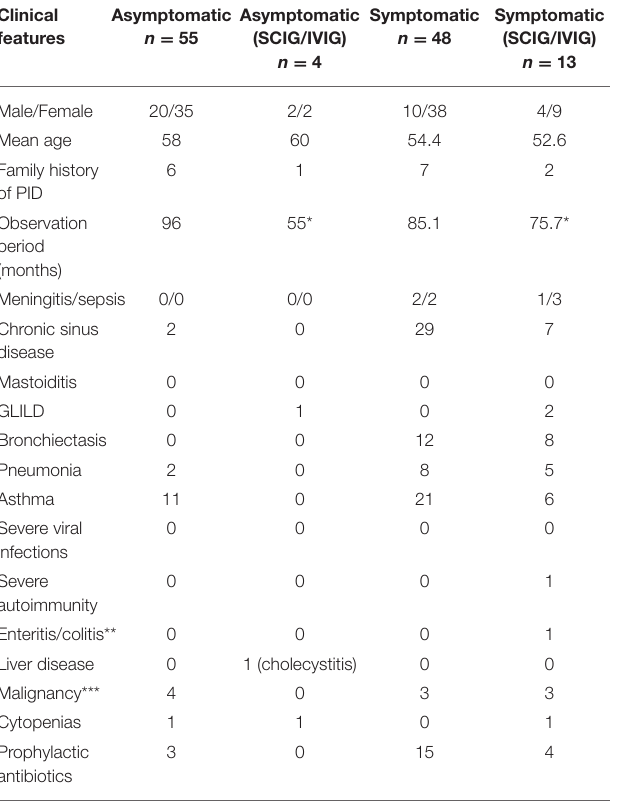
TABLE 1 | Clinical and laboratory characteristics of the patients in this study. Clinical features